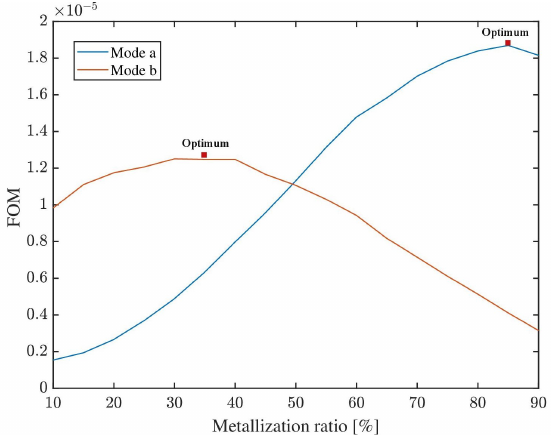
Figure 11. Arbitrary FOM shows the ability to optimize by means of metalization ratio.